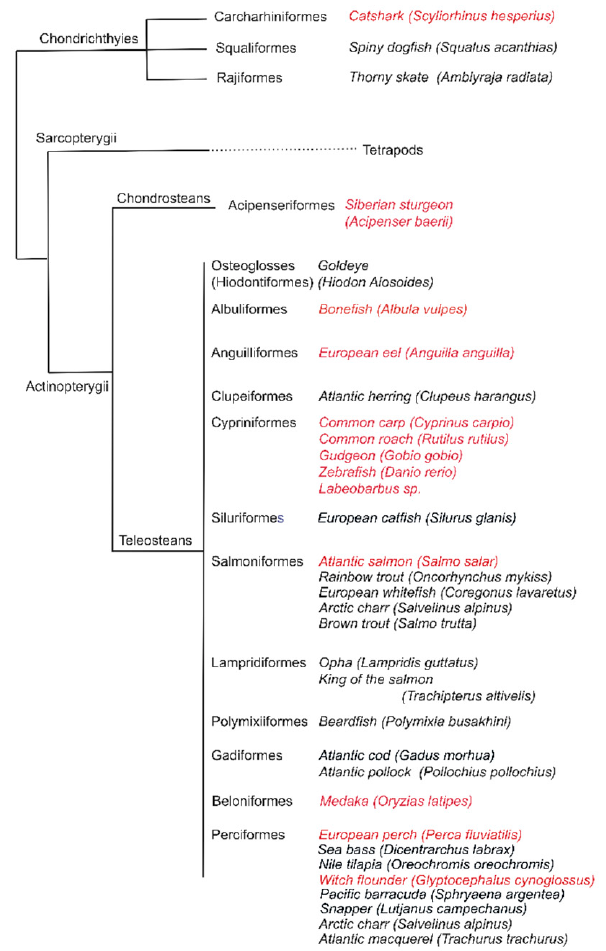
Figure 2. Gill-associated lymphoid tissue (GIALT) is omnipresent across fishes. GIALT was not found in the key group of cartilagenous fishes but was found in representatives of many different key groups across ray finned fishes ( Actinopterygii ), including Chondrosteans. Names in red are key species analyzed in detail in this work. Taxonomy as in [25].